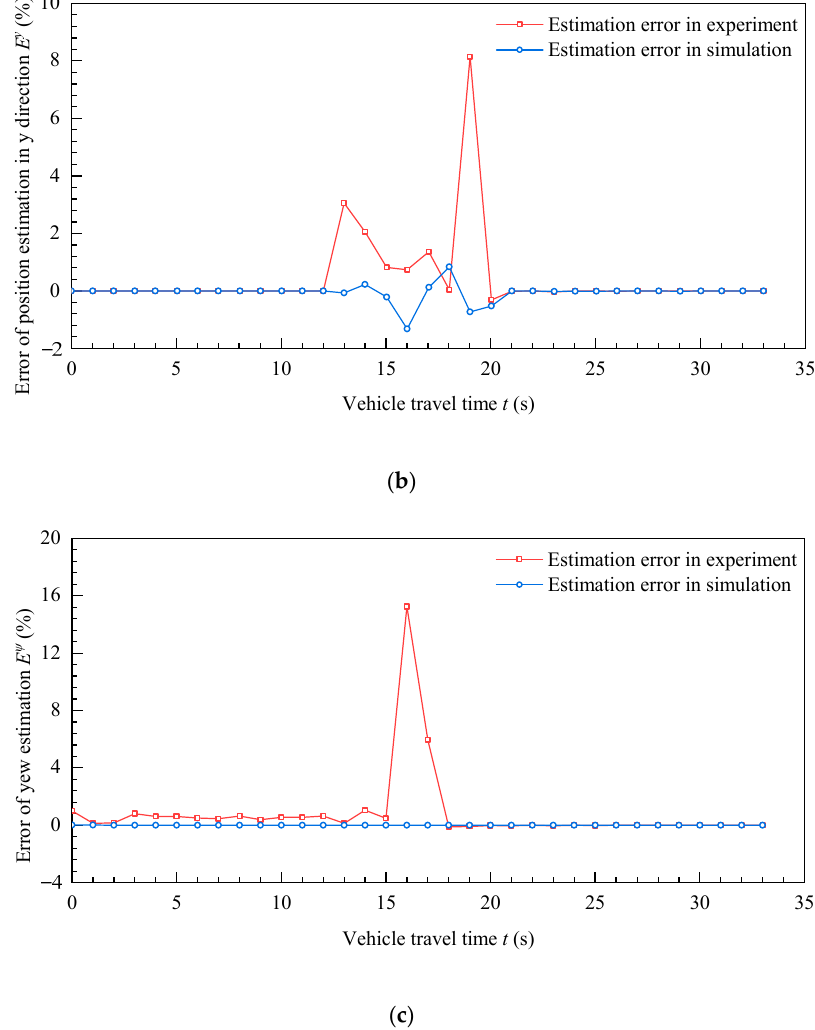
Figure 12. Position and attitude estimation error of quarter turn path. ( a ) Position estimation error in x direction. ( b ) Position estimation error in y direction. ( c ) Yaw estimation error.